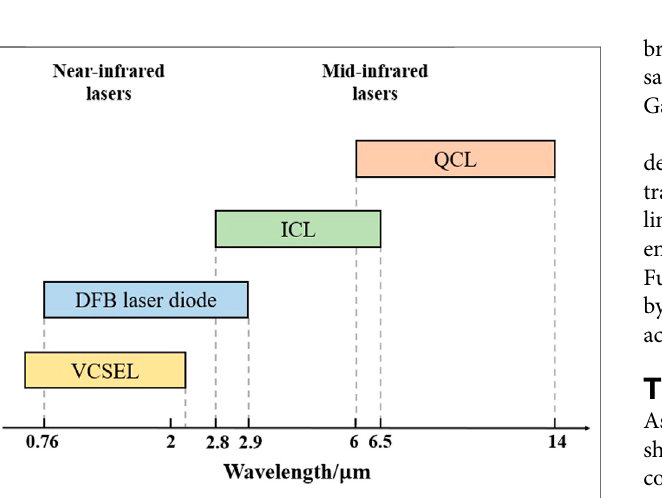
Frontiers in Physics |